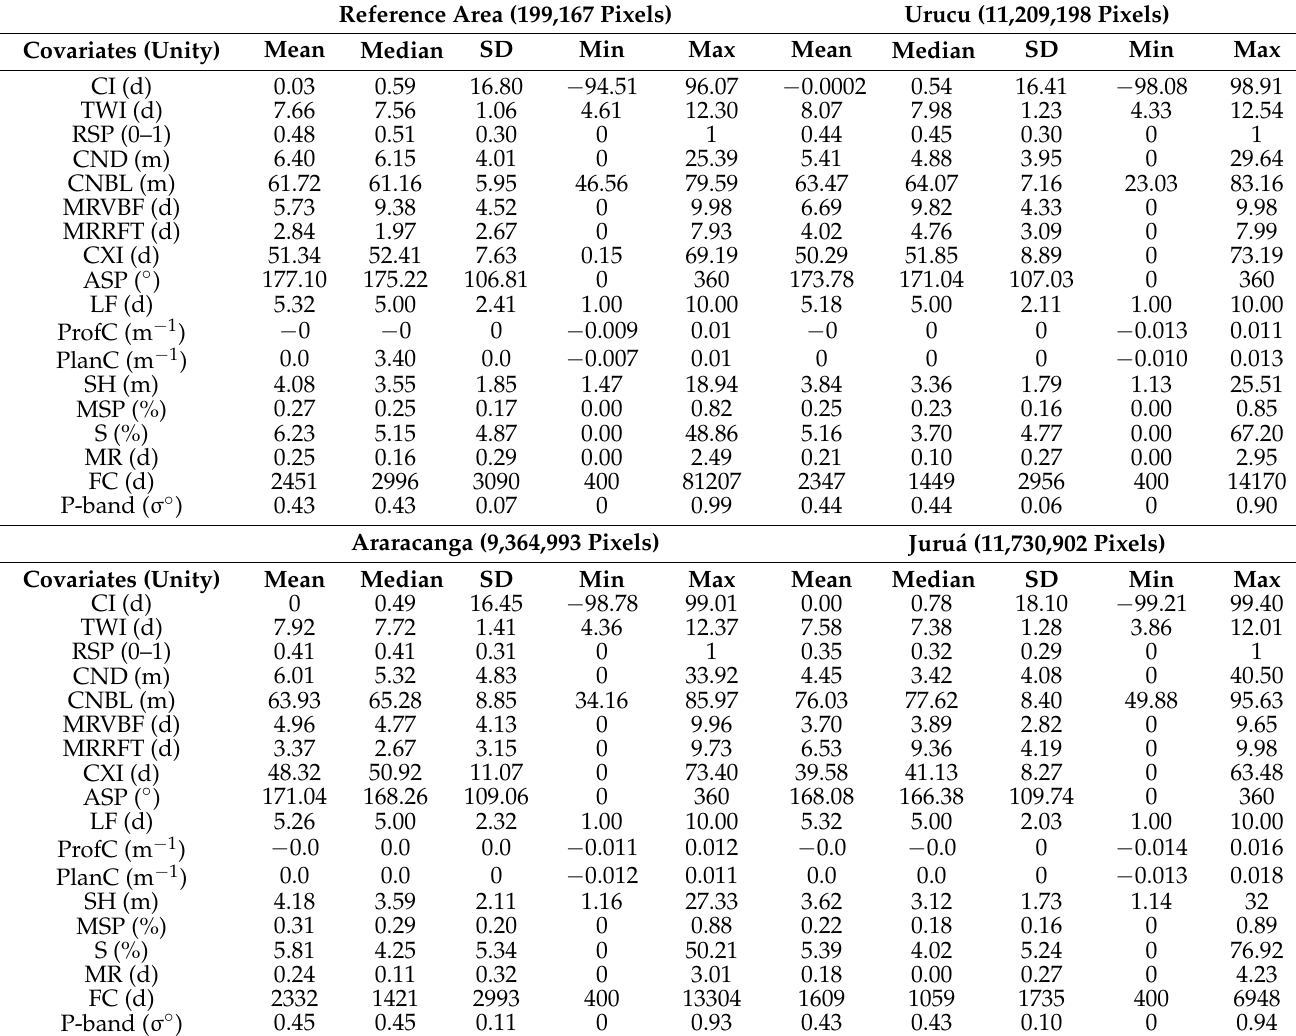
Table 4. Descriptive statistics of the covariates in the study area by